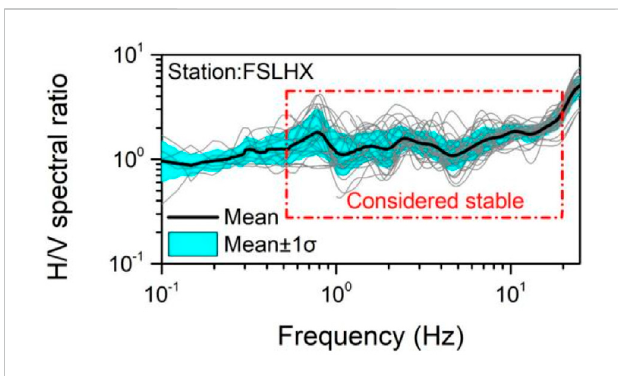
FIGURE 6 Horizontal-to-vertical (H/V) spectral ratios of the observed recordingsatFSLHXstation.Thedarksolidlineandthecyanshadedarea represent the mean and the range of mean plus or minus one standard deviation.